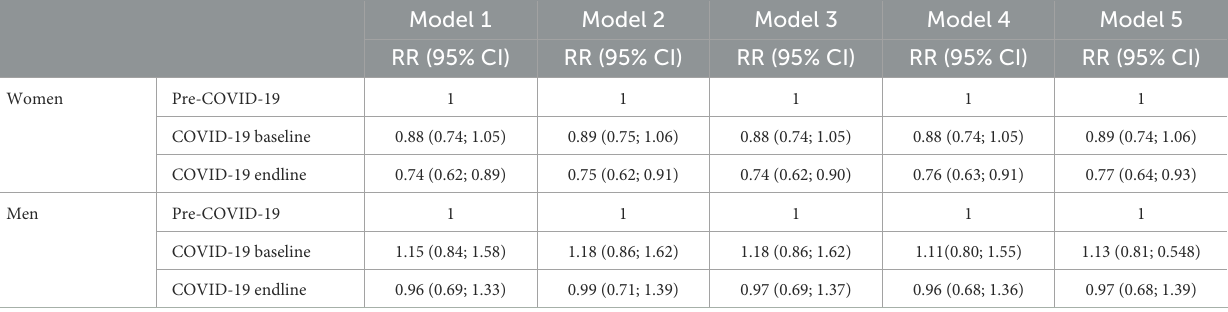
TABLE 5 Relative risk (RR) and 95% confidence interval (95% CI) of aggressions between time periods ∗ , according to sociodemographic and occupational variables, by